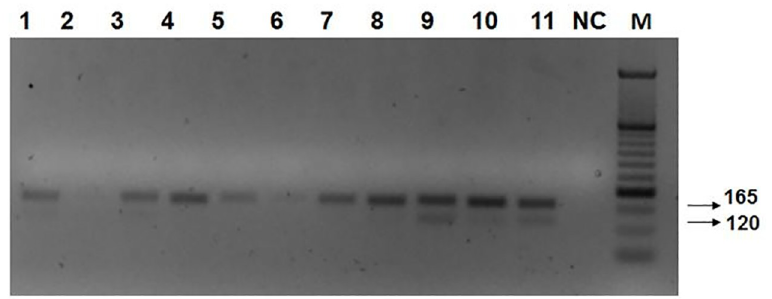
Fig 3. Multiplex PCR amplifying leishmanial kDNA gene sequences (120 bp) and the 12 SL RNA sand fly housekeeping gene (165 bp) in representative sand flies from different districts of the West Bank: NC, PCR negative control; M, molecular weight